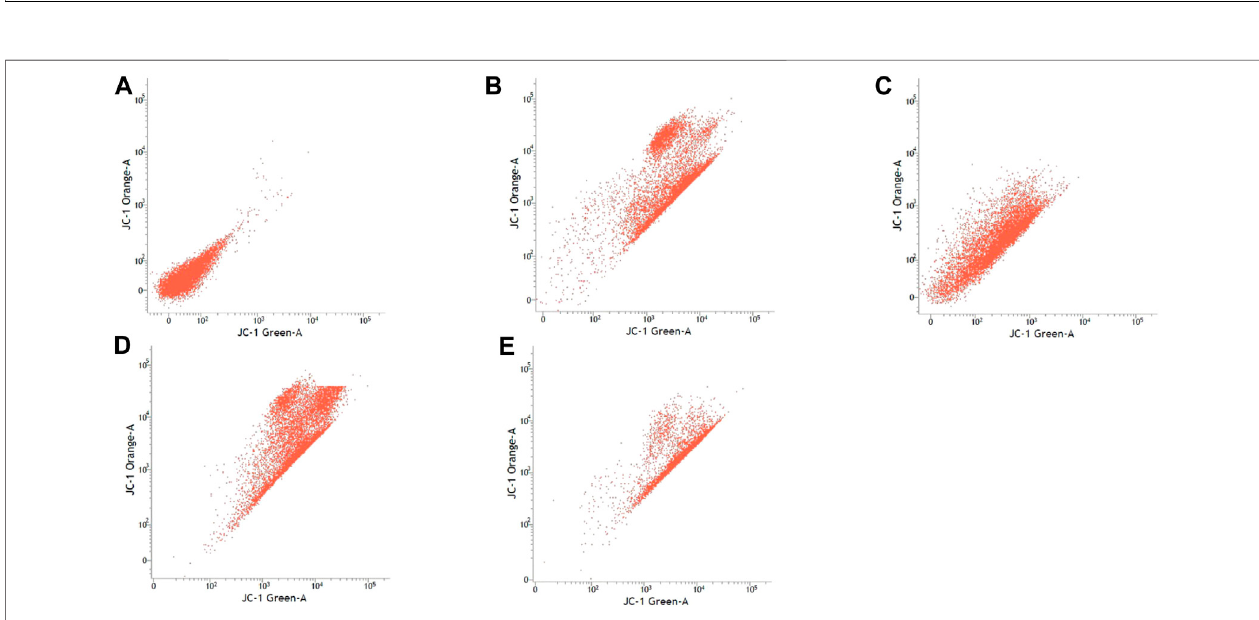
FIGURE4| SK-N-MC celllineswithor withouttreatmentwithsialicacidusingJC-1MitoProbe byBDFACSAria ™ : (A) untreated cell; (B) control withoutCCP; (C) control with CCP; (D) treatment with standard sialic acid; (E) treatment with extraction of sialic acid.